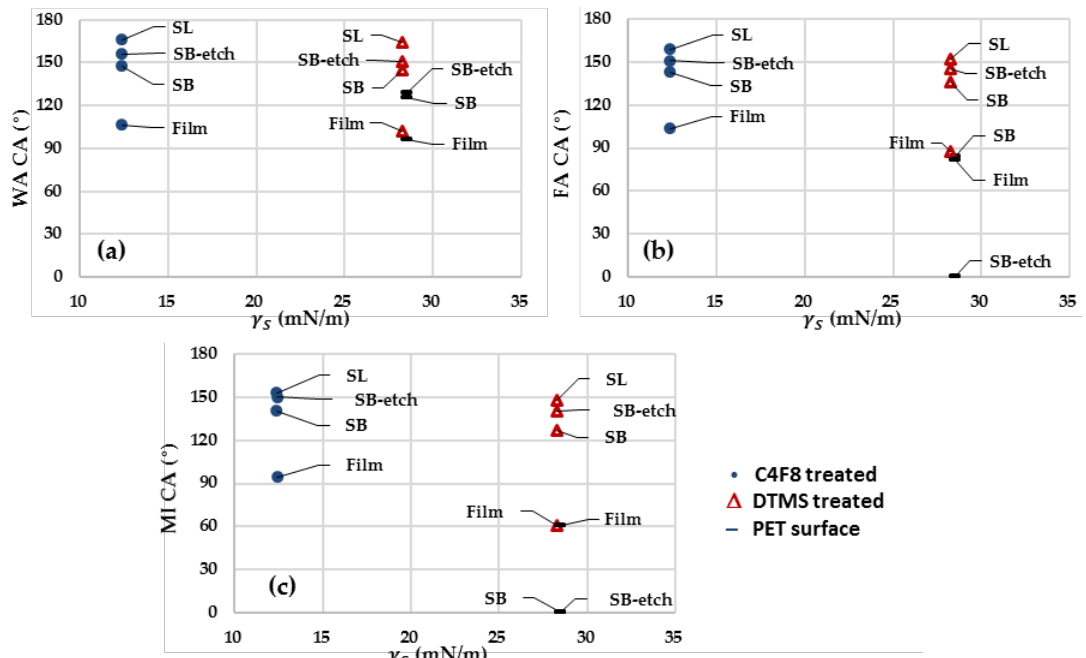
Figure 8. Wettability of substrates with different surface energy and roughness profiles.